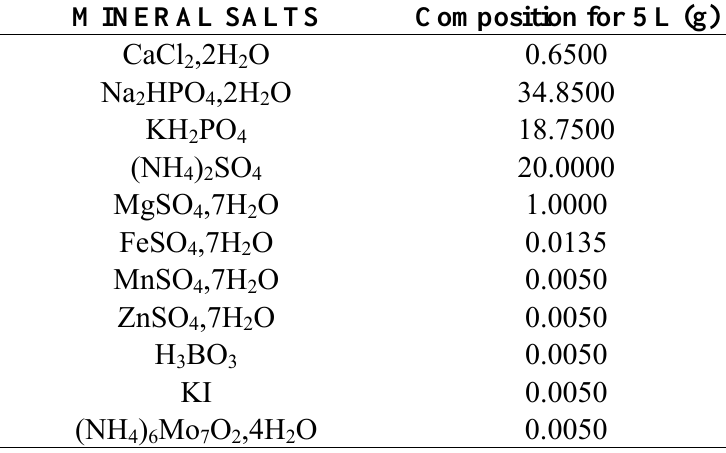
Table 2. Composition of the mineral solution for inert solid medium tests.